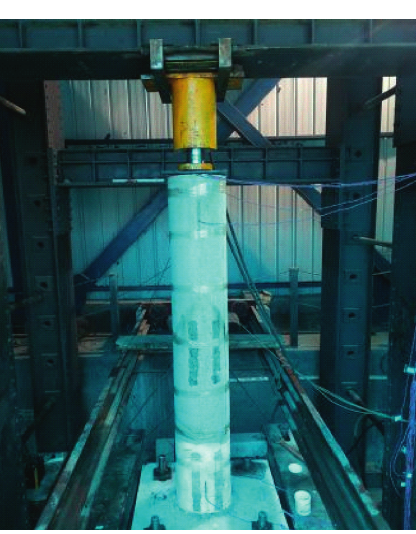
Figure 6: Scale modes of the pier